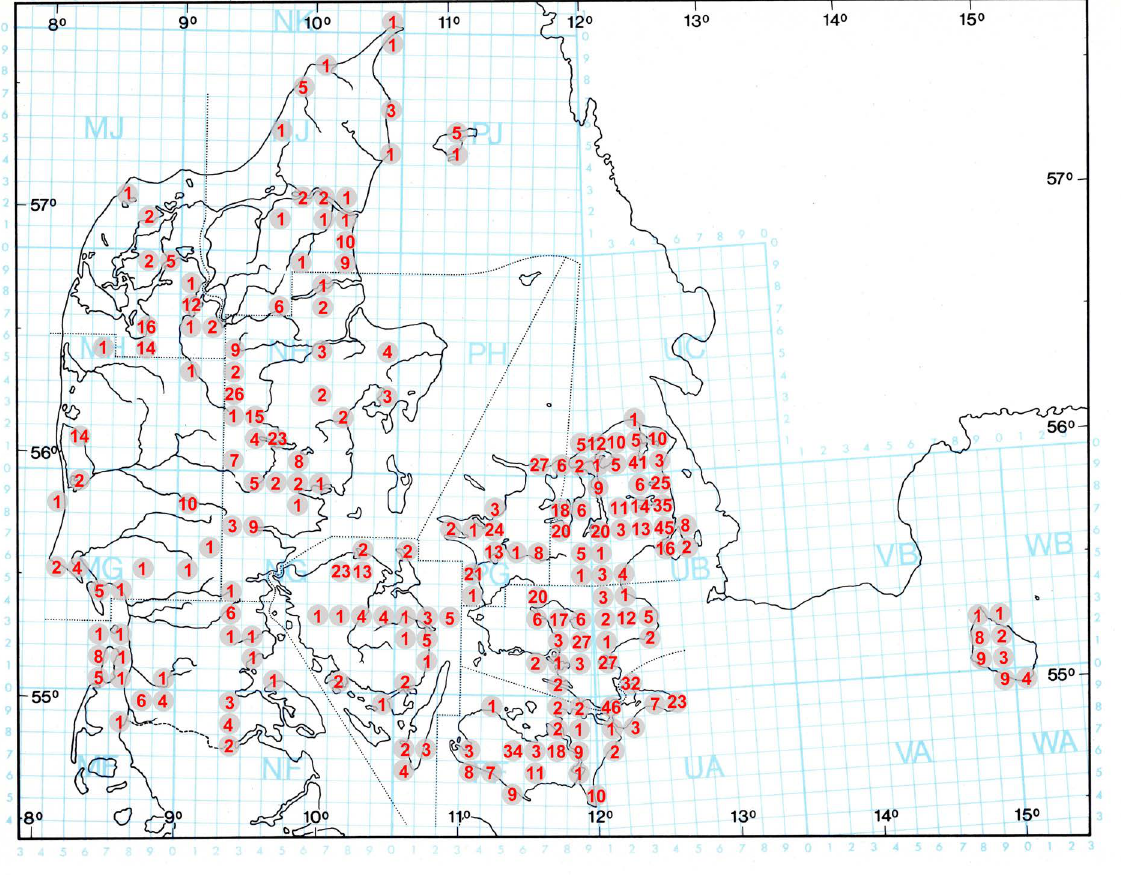
Fig. 93. Number of species of Laboulbeniomycetes in UTM 10×10 km